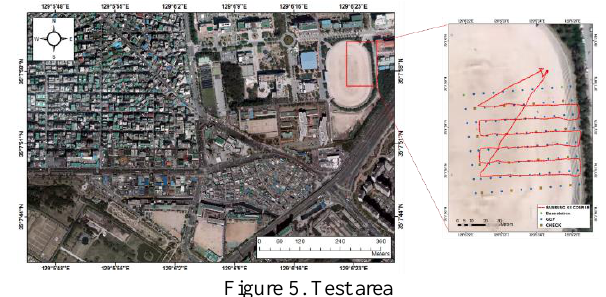
Figure 5. Test area